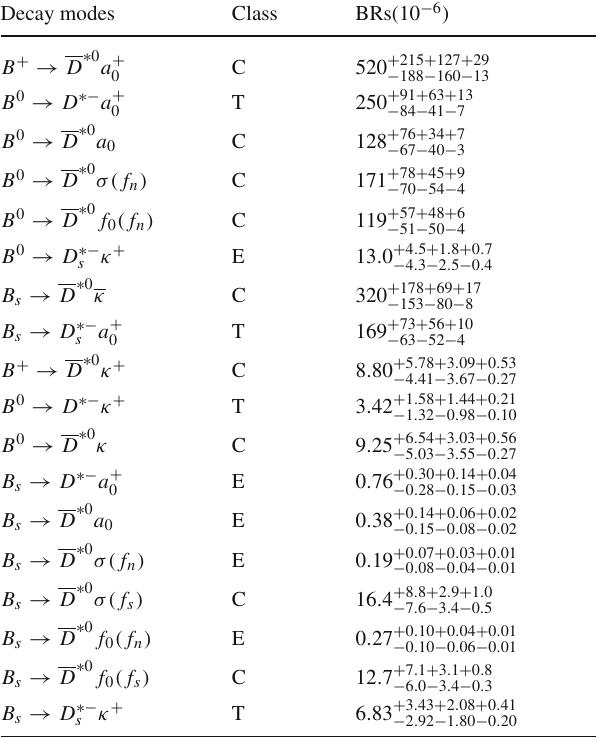
Table 3 Branching fractions of B q → D culated in the PQCD approach in S1 Decay